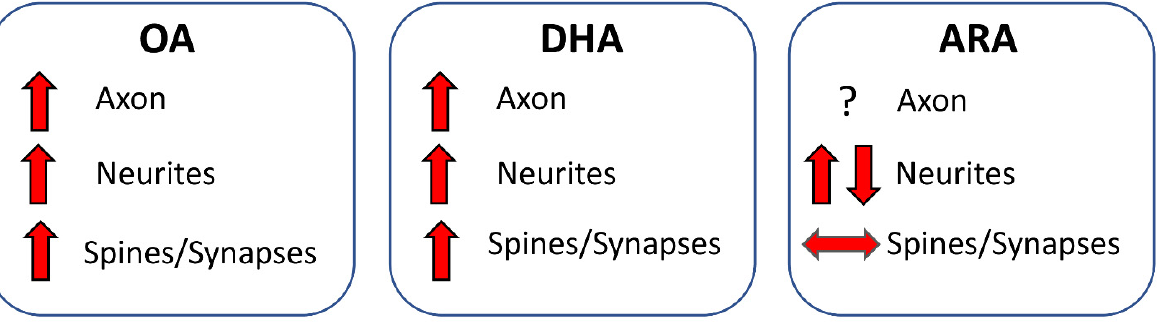
Figure 5. Summary of the effects of fatty acids on neuron maturation. Abbreviations: ARA, arachidonic acid; DHA, docosahexaenoic acid; OA, oleic acid. The upward pointing arrow indicates an increase. The downward pointing arrow indicates a reduction. The double-headed horizontal arrow means no effect.